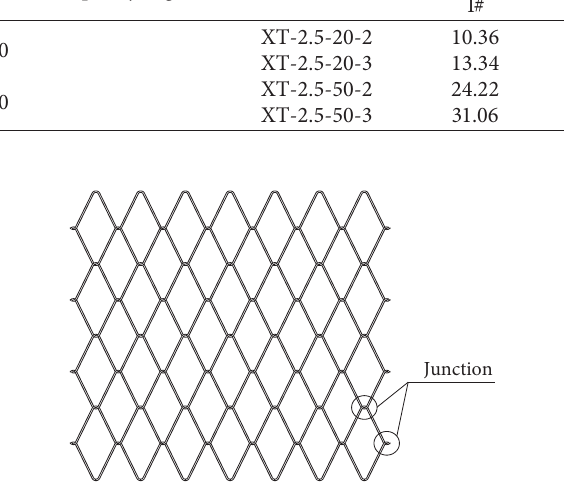
Figure 4: The rock fall slant impact under XT-2.5-20-3 condition. (a) The rock fall is hoisted. (b) The metal flexible net achieves maximum deformation. (c) Rock fall rebound. (d) The rock fall is ejected by the metal flexible net. Table 2: The comparison table of the maximum instantaneous impact forces of the supporting ropes under different working conditions. Rock fall quality (kg)